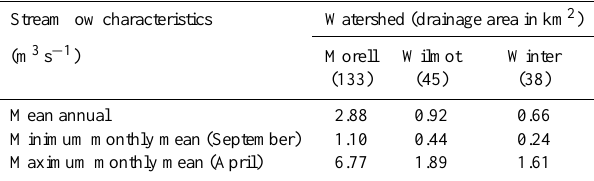
Table 3. Streamflow characteristics of selected rivers in Prince Ed- ward Island (records are for 1972 to 2005, 1961 to 1995 and 1965 to 1991 for Wilmot, Morell, and Winter rivers, respectively). See Fig. 1 for locations of the